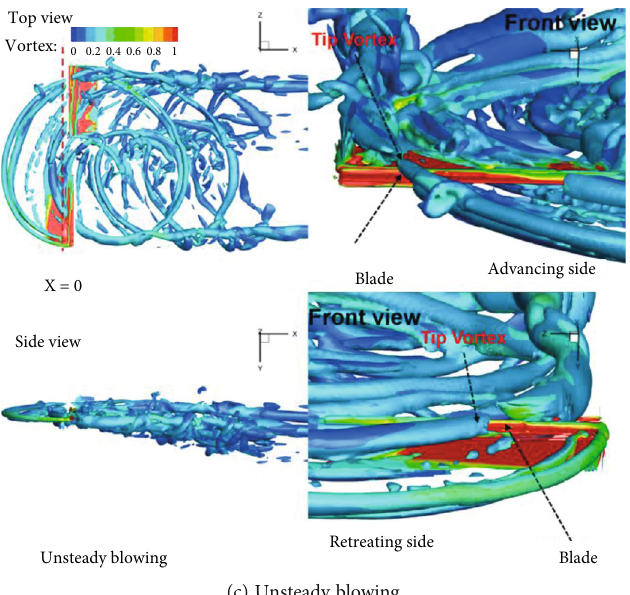
Figure 12: Vortex structure from several perspectives for the steady/unsteady blowing cases (isosurfaces of the Q criterion at Q = 0 : 001 , colored by vorticity magnitude).